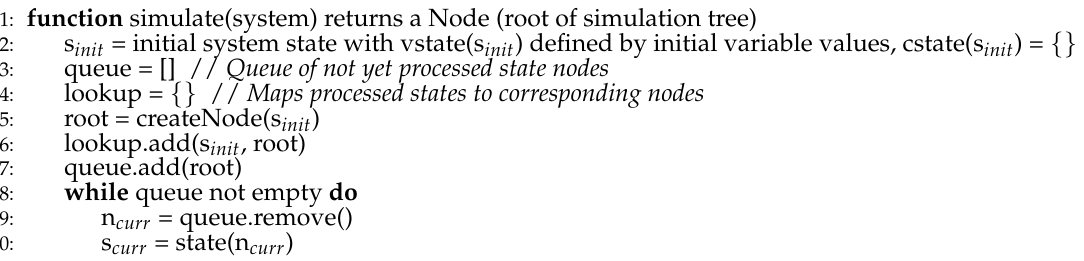
Algorithm 1 The simulation